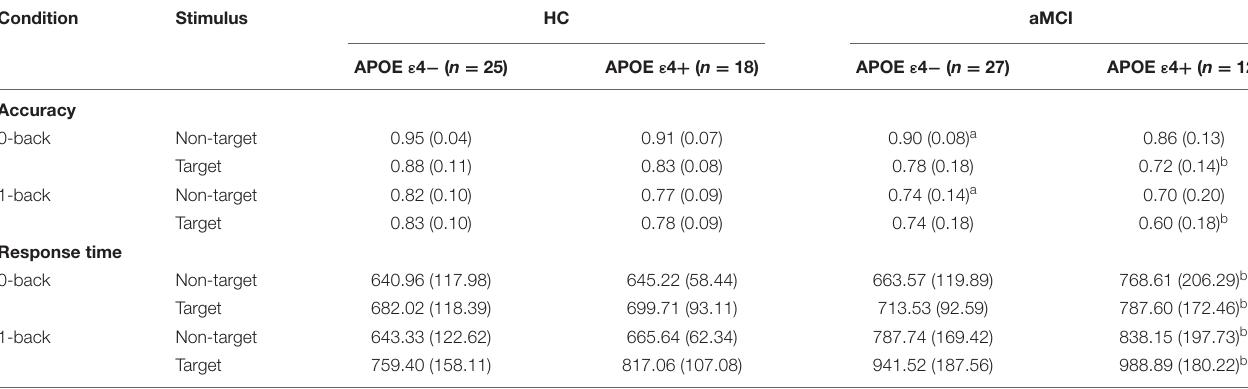
TABLE 2 | Behavioral data [accuracy and response time (RT)] for healthy controls and aMCI patients with different APOE ε 4 status.